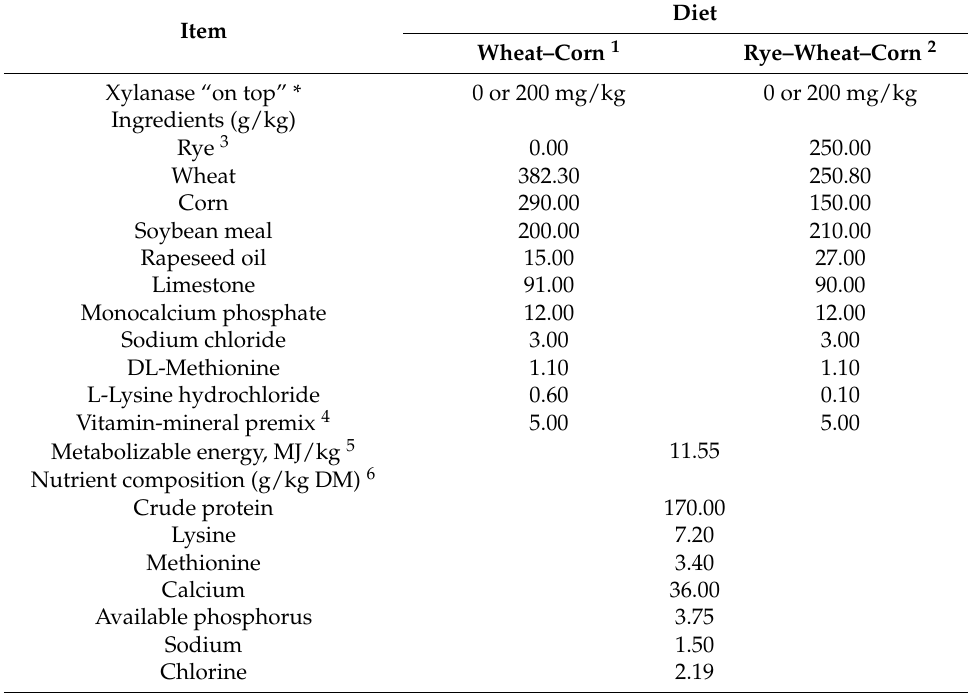
Table 1. Composition and calculated nutritional value of experimental